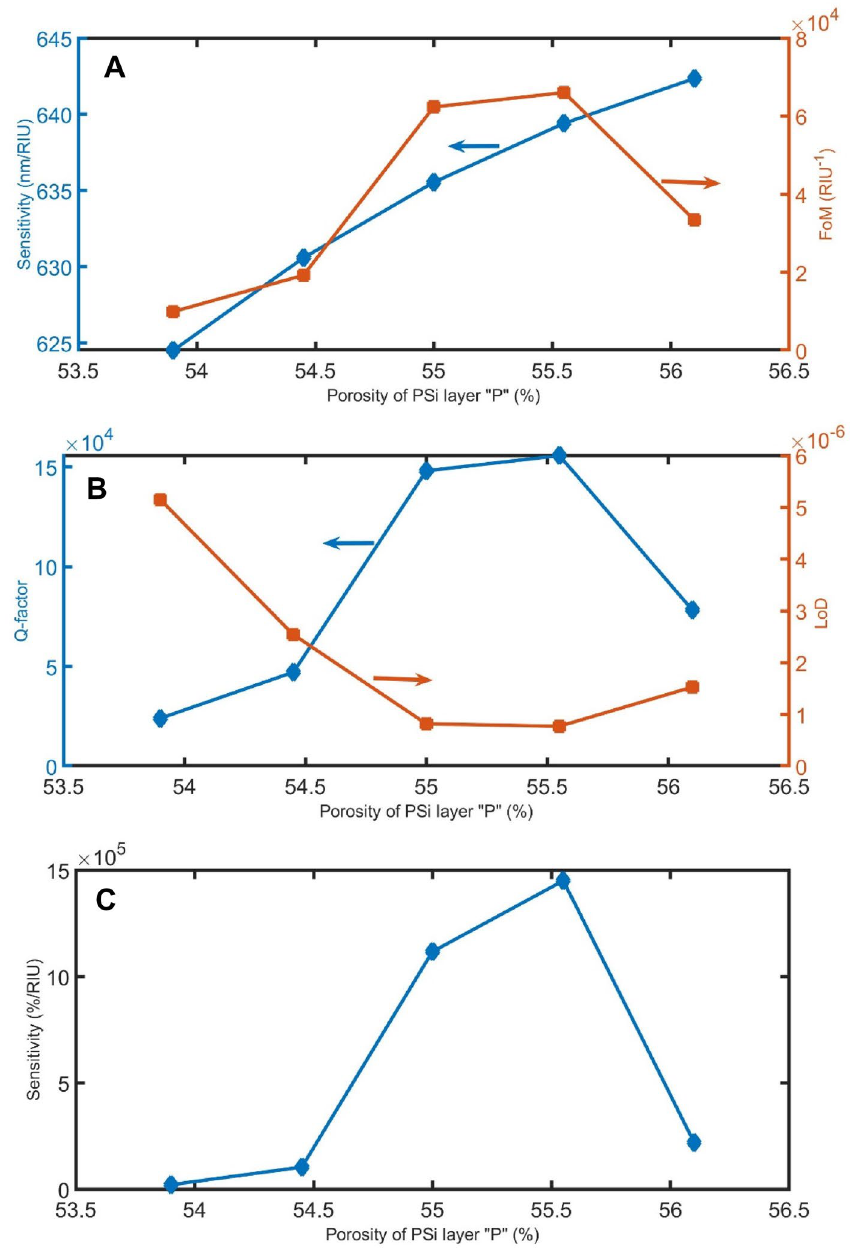
Figure 12. The ( A ) sensitivity in nm/RIU and FoM, ( B ) Q-factor and LoD, and ( C ) sensitivity in %/RIU, with varying the porosity of